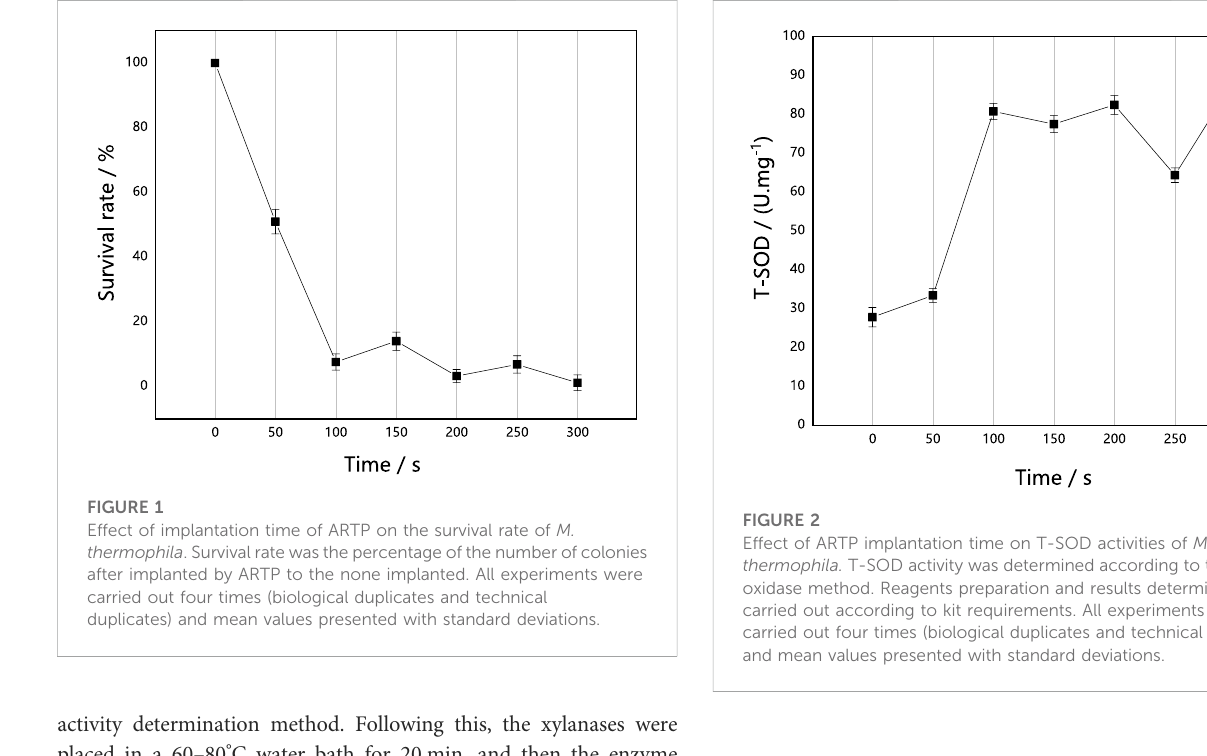
placed in a 60 – 80 ° C water bath for 20 min, and then the enzyme